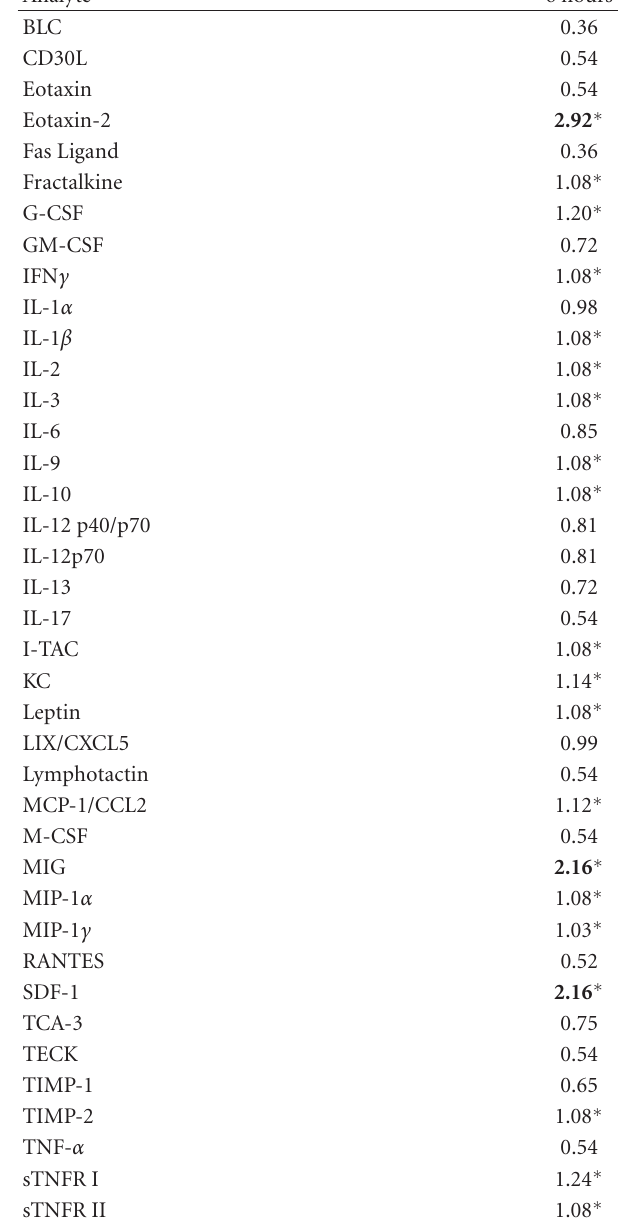
1 Air pouches were created and lining cells were harvested. pooled and incubated in vitro with 250ng/ml IL-4 for 6 hours. The supernatant was used to probe the membranes (Mouse inflammation antibody array I) no more than two weeks after the in vivo experiments. Results are calculated as ratios, as described in Materials and Methods. ∗ , ratio above 1; numbers in bold characters, ratio ≥